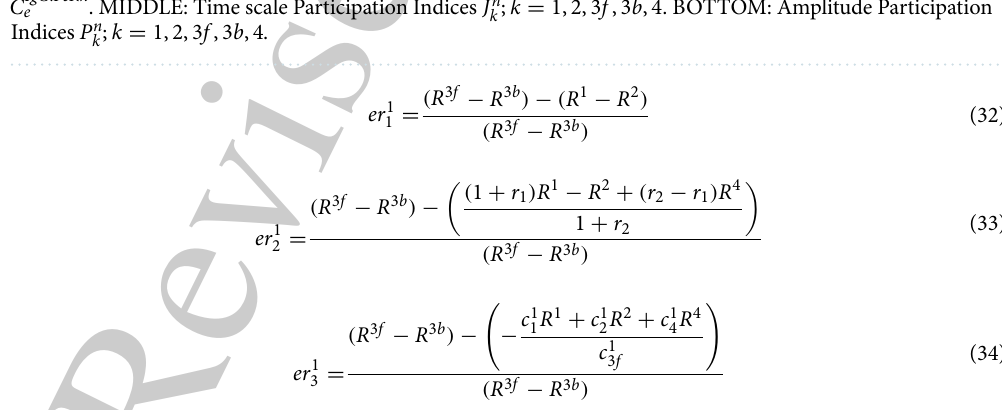
IgG IgG FcRn e , C p , C e ,